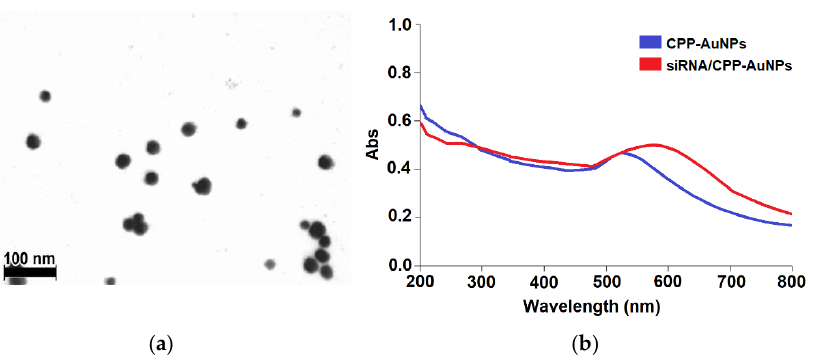
Figure 1. ( a ) TEM image of CPP-AuNPs and ( b ) absorption analysis with UV-Vis spectroscopy: CPP-AuNPs (blue line) and siRNA/CPP-AuNPs (red line).